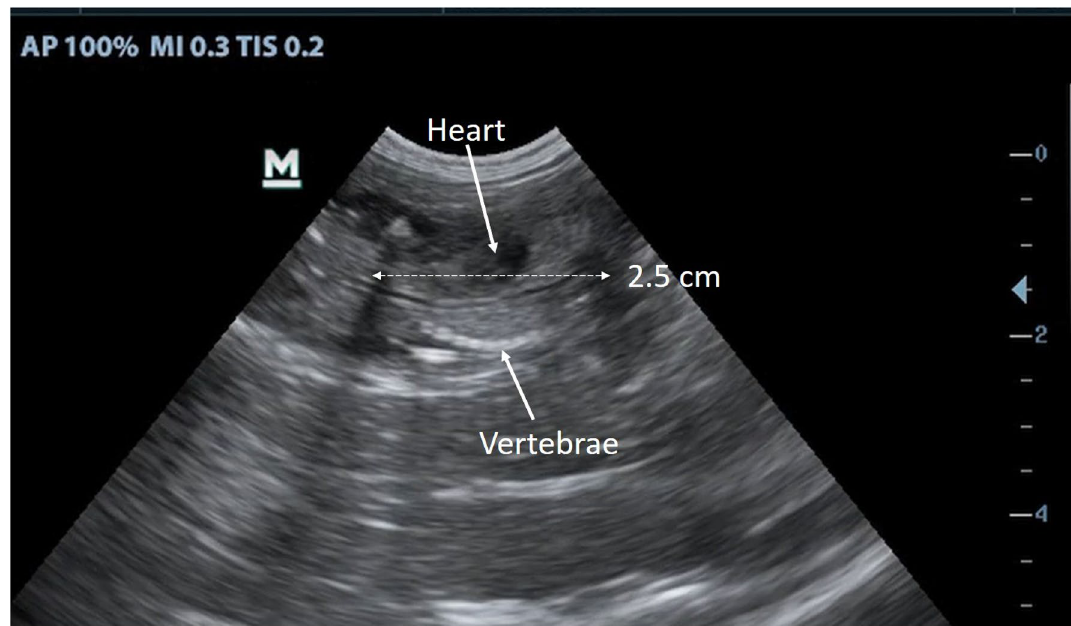
Figure 2. Ultrasonic image and embryo measurements of a female Chinese pangolin Manis pentadactyla (LF28) on 15 August 2015. LF28 then gave birth on 8 December 2015.